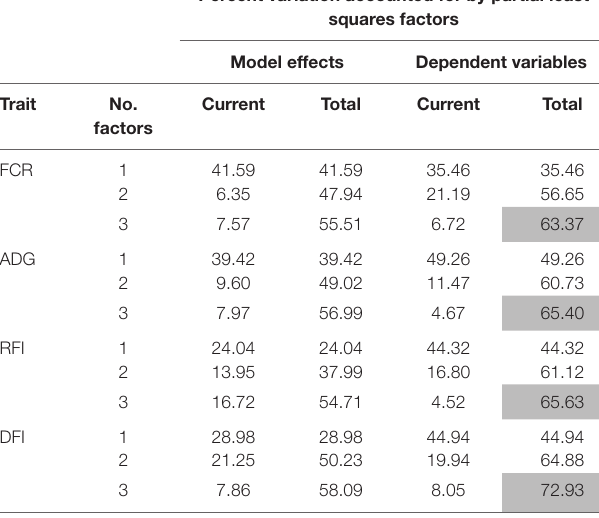
TABLE 1 | Percentage of variation in each trait explained by the microbial genes identified in the partial least squares (PLS). Percent variation accounted for by partial least squares